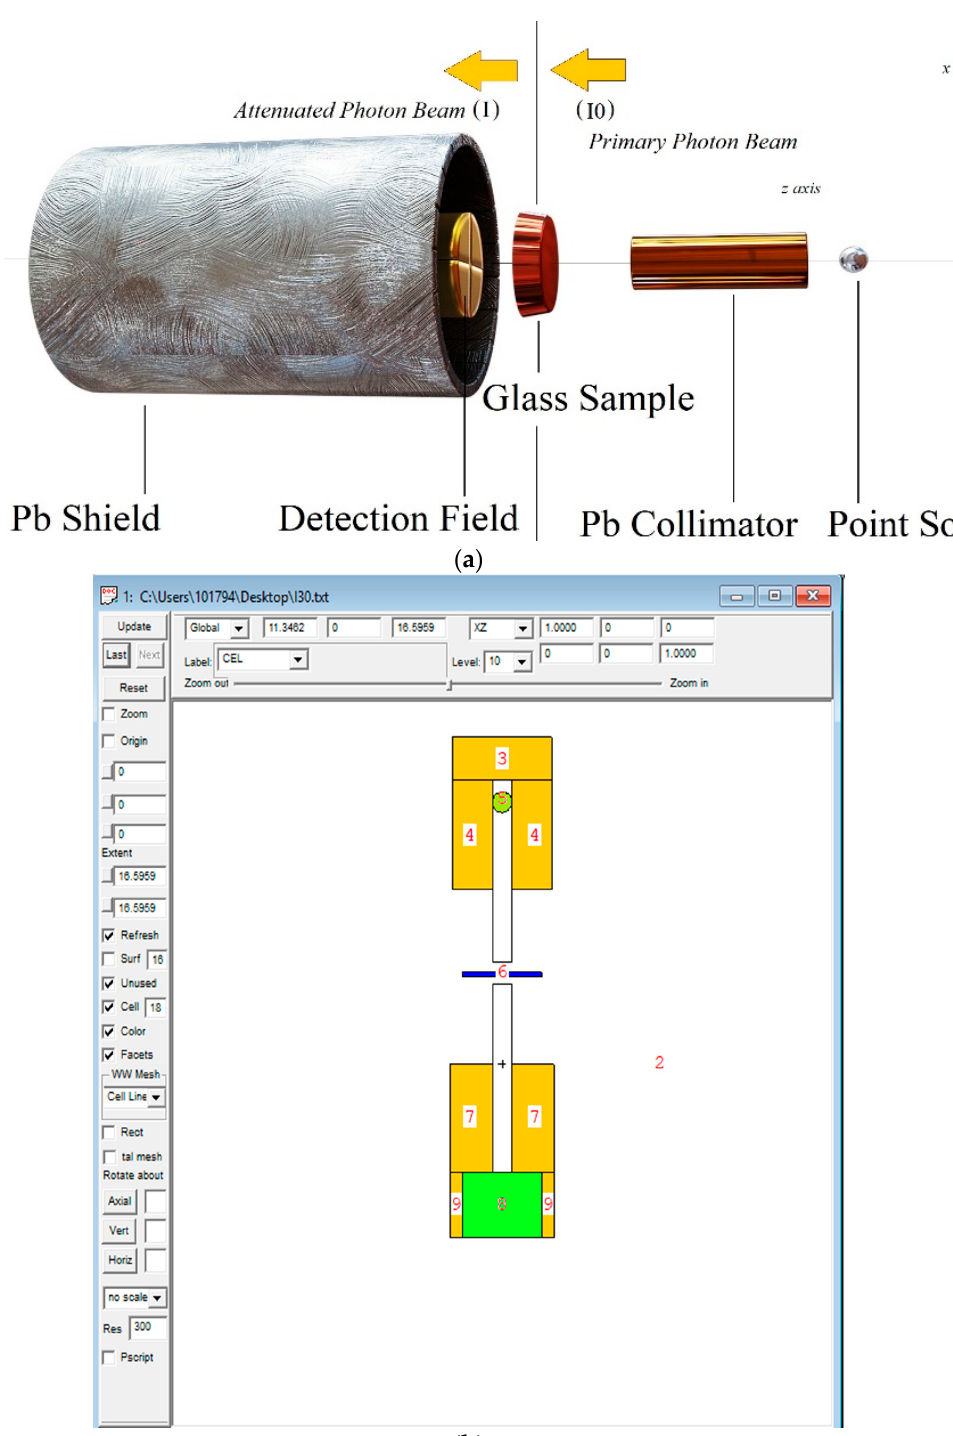
Figure 1. ( a ) Photon transmission setup for µ/ ρ simulations of investigated glasses (3-D view) ( b ) MCNPX simulation setup (2-D view) of µ/ ρ computations obtained from MCNPX Visual Editor (version X_22S).